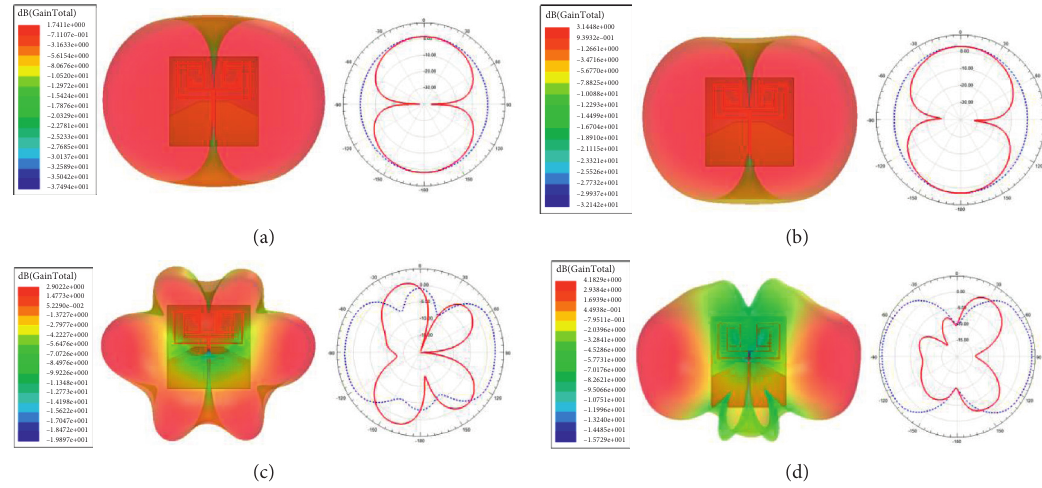
Figure 7: 3D gain radiation pattern and EH surface pattern of the antenna: (a) 1.55GHz, (b) 2.4GHz, (c) 5.05GHz, and (d)